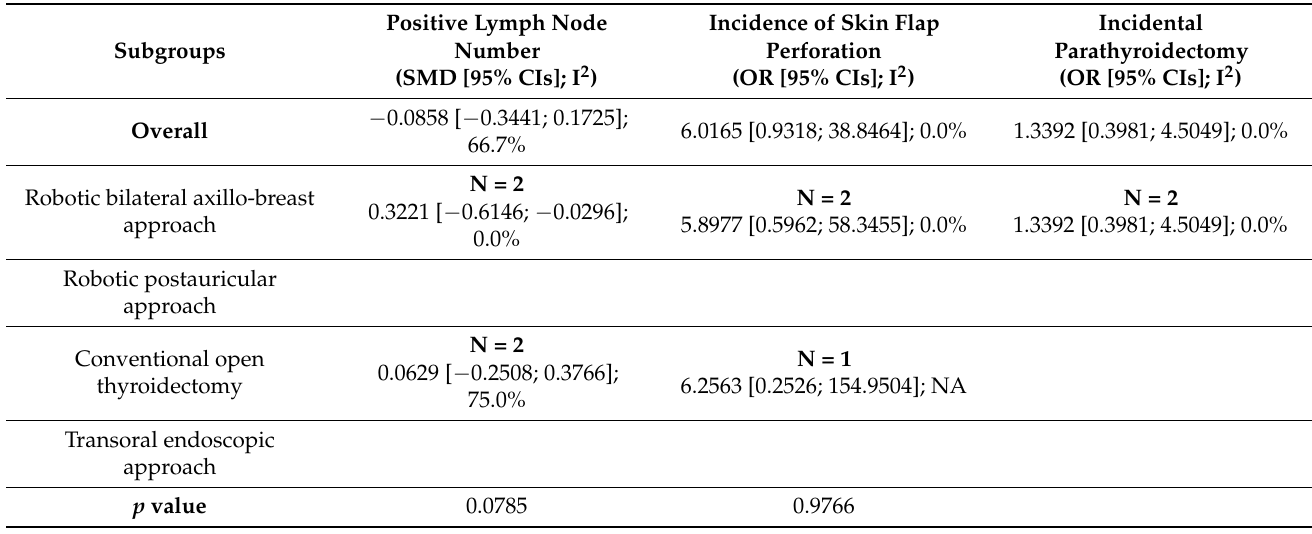
Figure 2. Funnel plot for publication bias of operative time ( a ), retrieved lymph node number ( b ), and temporary vocal cord palsy ( c ). Table 2. Subgroup analysis of operation-related measurements according to the comparison with other operative